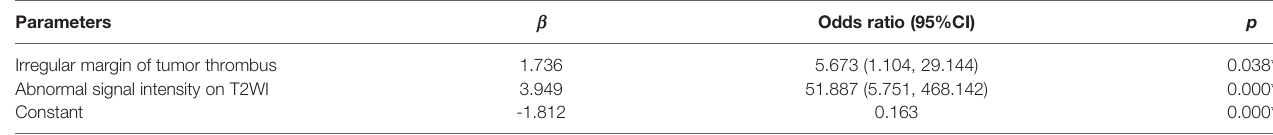
TABLE 2 | Independent predictors with the radiological model for inferior vena cava wall invasion in the training cohort. Parameters Irregular margin of tumor thrombus